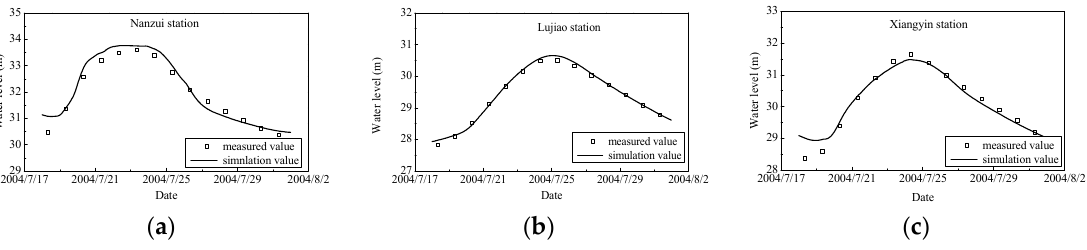
Figure 2. Comparisons of time series of water elevation between predictions and measurement during the wet season. ( a ) the Nanzui station; ( b ) the Lujiao station; ( c ) the Xiangyin station.